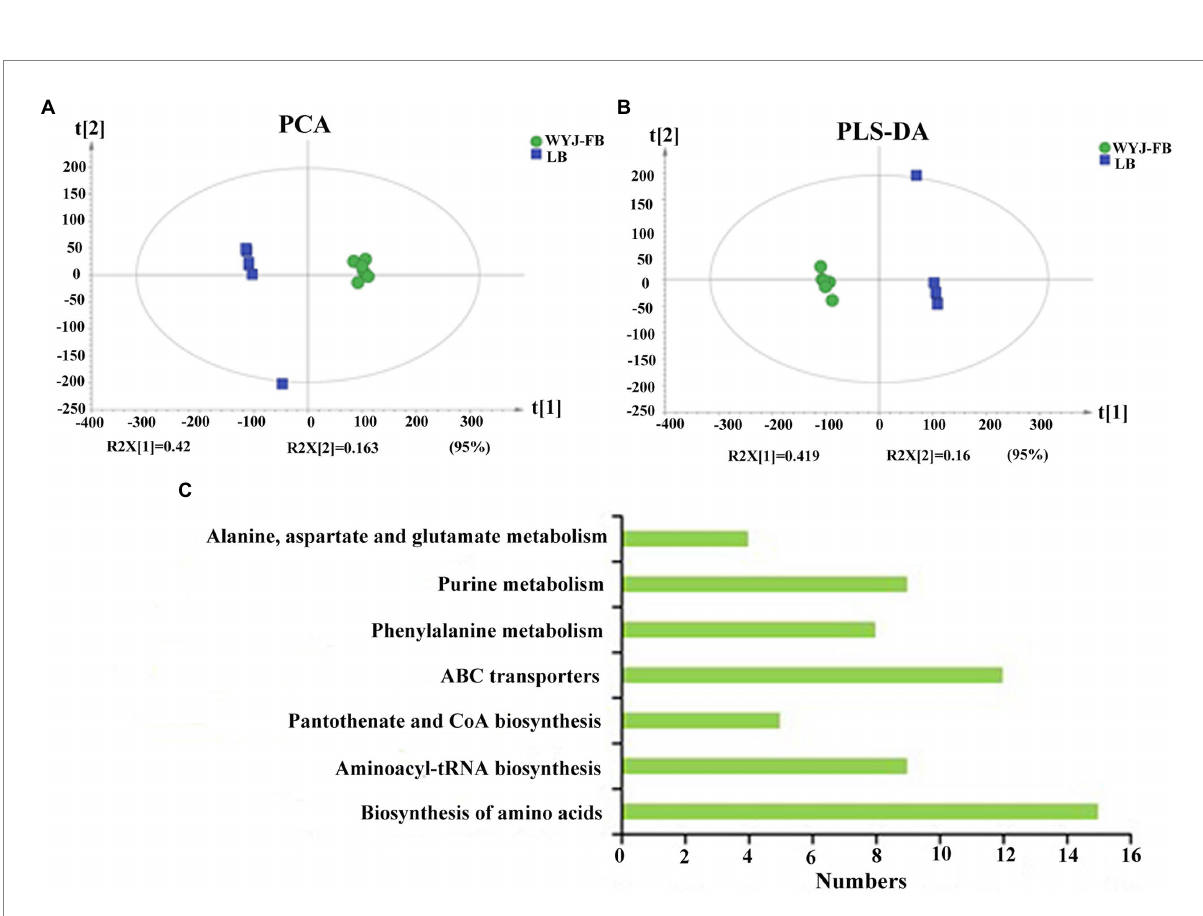
FIGURE 4 The metabolome analysis between WYJ-FB and LB medium. (A) PCA of the corrected and filtered data showed an obvious separation between WYJ-FB and LB medium. (B) The goodness-of-fit (R2) and predictability (Q2) of the PLS-DA models. (C) The KEGG pathway analysis of the identified differential metabolites produced by Rhizobium sp.